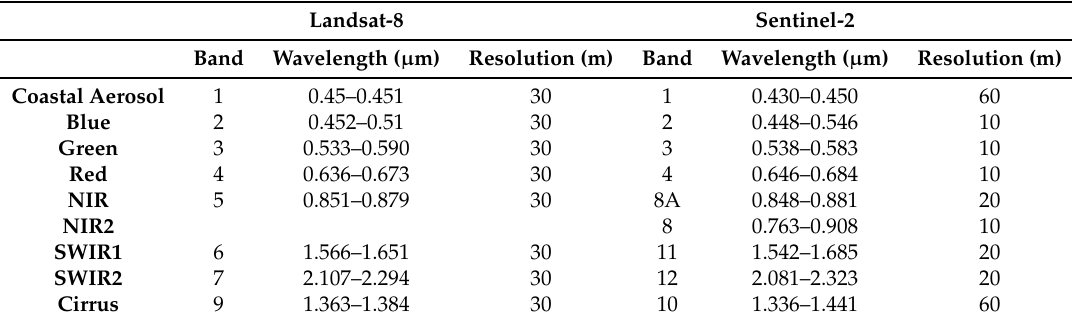
Table 1. Corresponding Landsat-8 and Sentinel-2 bands and